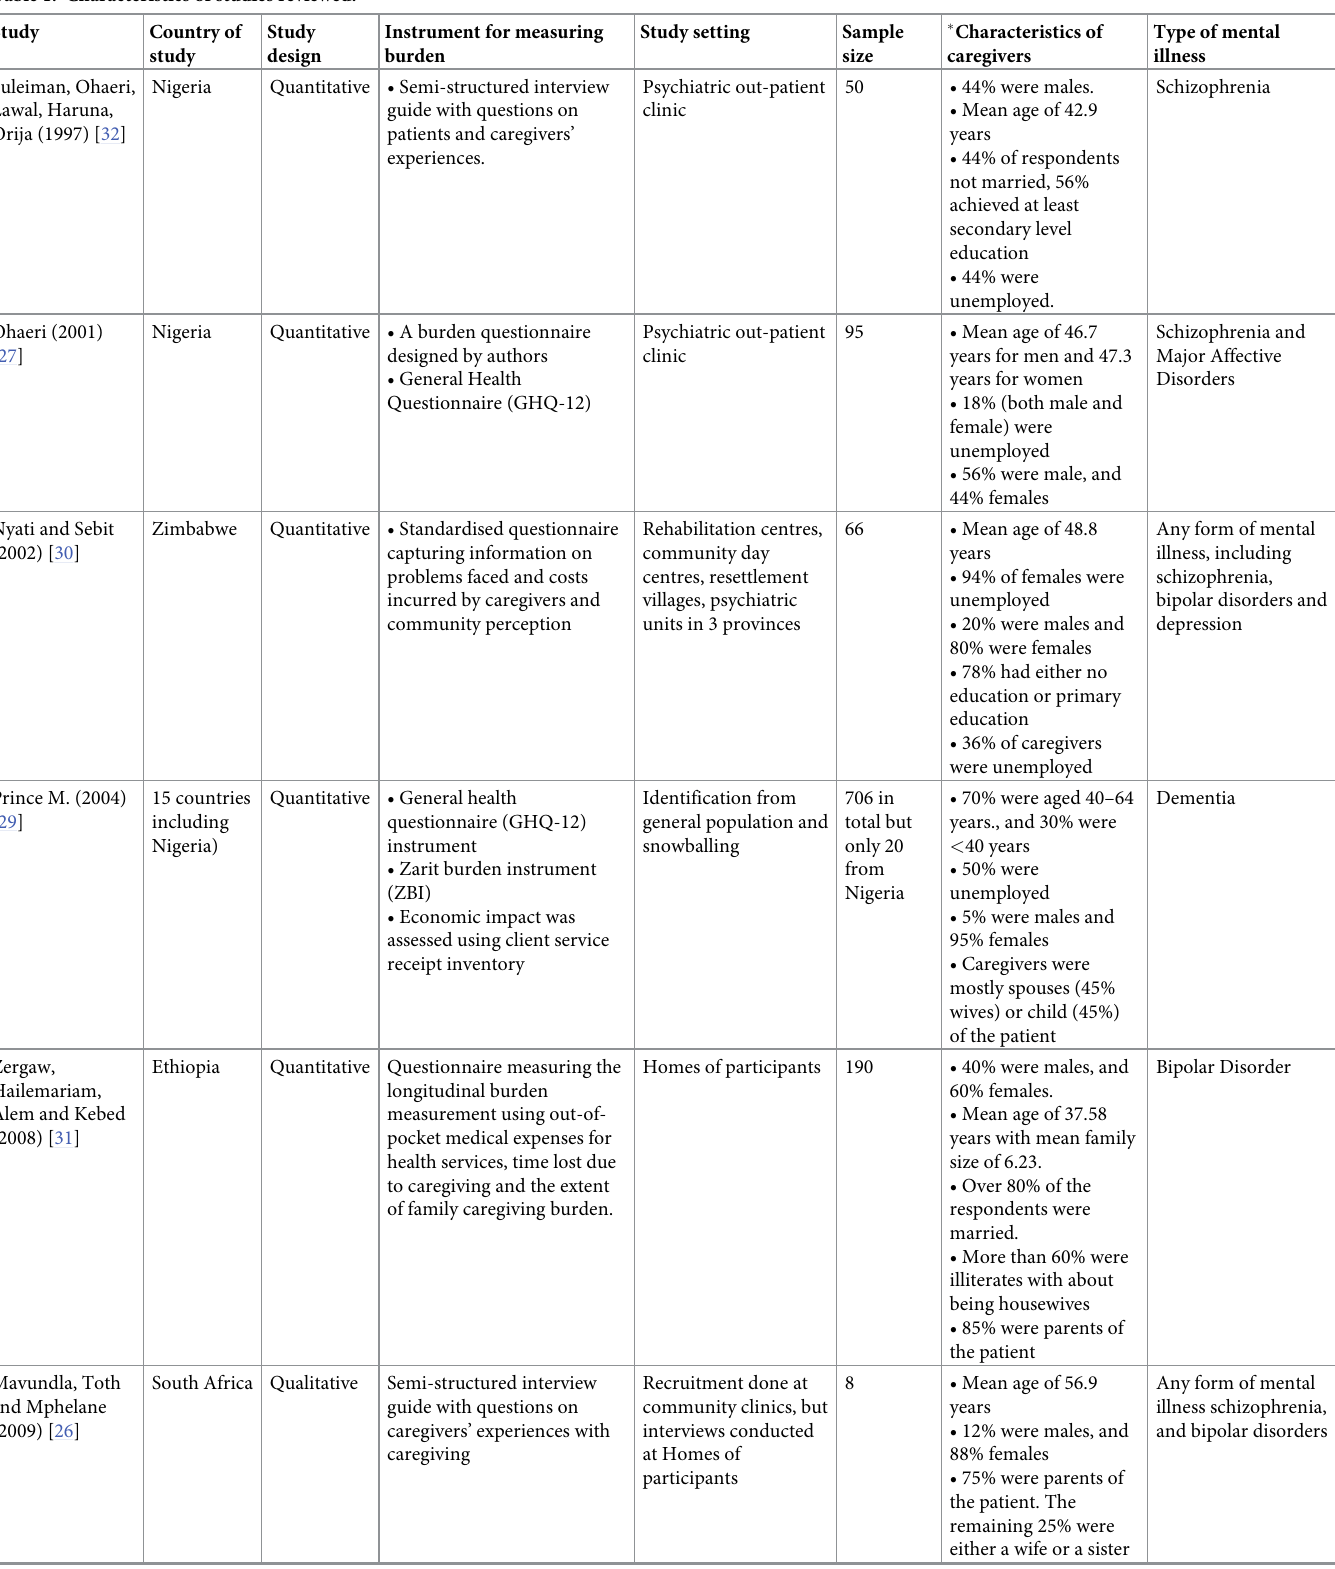
Table 1. Characteristics of studies